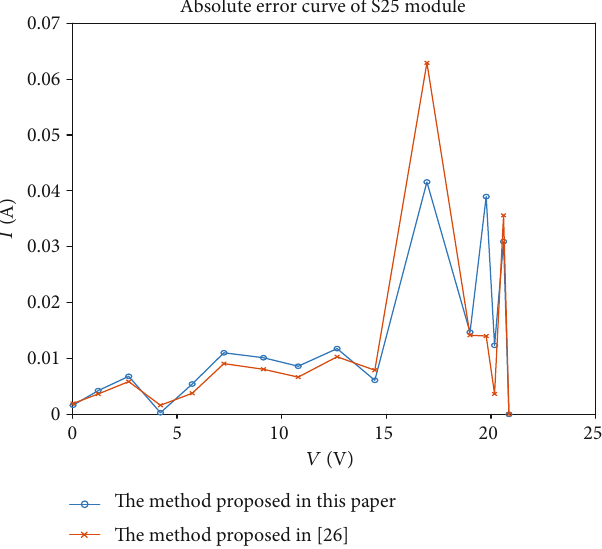
Figure 11: Absolute error comparison of S25 module with di ff erent extraction methods under